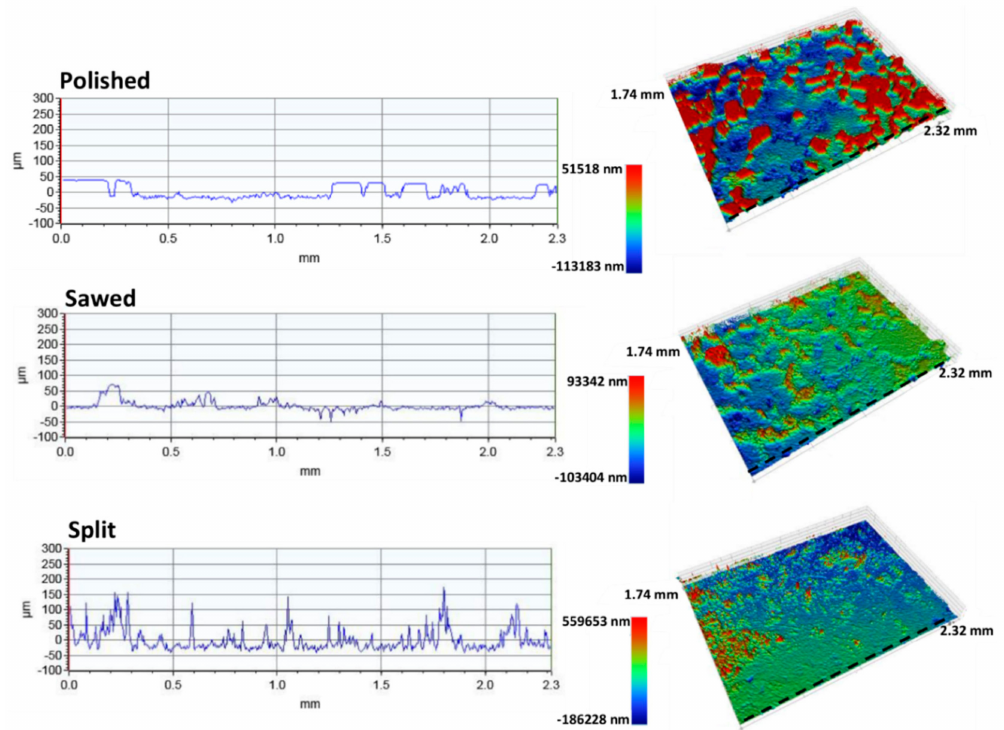
Figure 8. Surface roughness profiles and corresponding 3D models of the polished, sawed, and split surfaces of the Gildehaus sandstone. Note that the 3D models have different topographic scales. Dashed line indicates location of the topographic